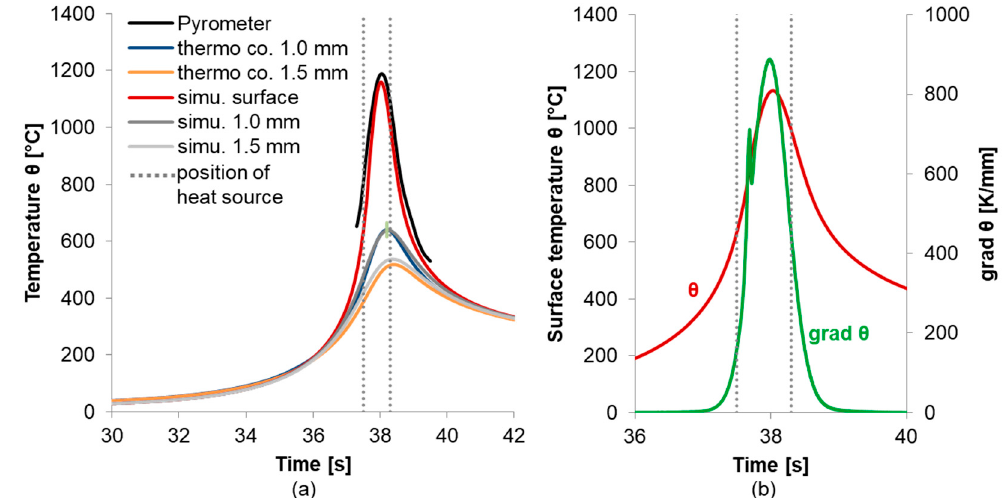
Figure 8. ( a ) Temperature measurement for process with l g = 1.48 mm (fiber core diameter 600 µ m), v ft = 2 mm/s, 1000 W laser power, absorbed power P total 325 W (simulation), Gaussian power profile with standard deviation of 523 µ m, ( b ) simulated temperature and temperature gradient at surface. The dashed lines indicate the current position of the laser beam.